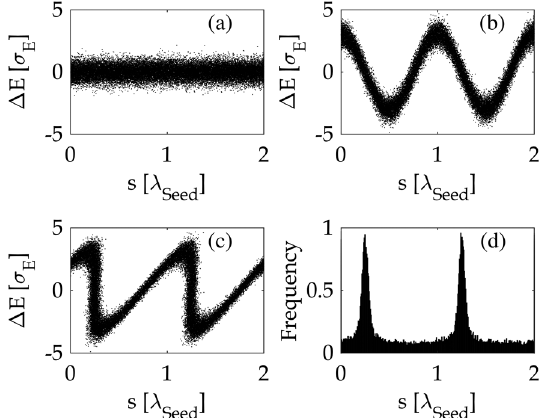
FIG. 2. Evolution of the longitudinal phase space distribution during the HGHG process. The horizontal axis is the bunch coordinate s in units of seeding wavelength λ vertical axis shows the deviation from the central energy Δ E in units of the uncorrelated energy spread σ spread at 3 locations a , b , and c as indicated in Fig. 1 and a histogram of the electron density at location c in (d). One can see that a larger fraction of the electrons is confined within distances smaller than the seed wavelength, thus having a higher harmonic